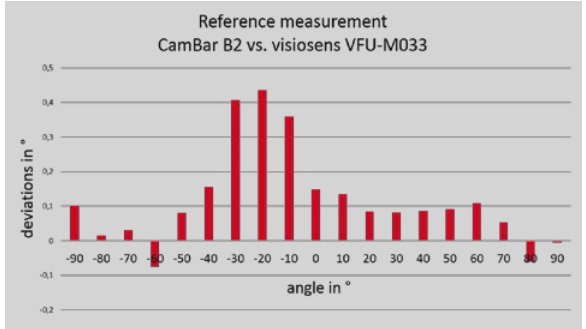
Figure 4. Reference measurement; deviations of the horizontal angle